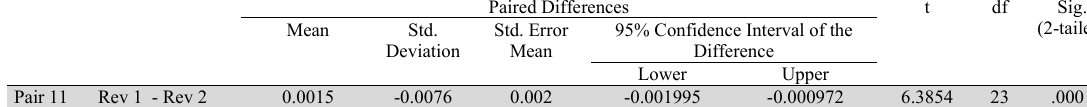
Paired sample T-test SMEs revenue per employee